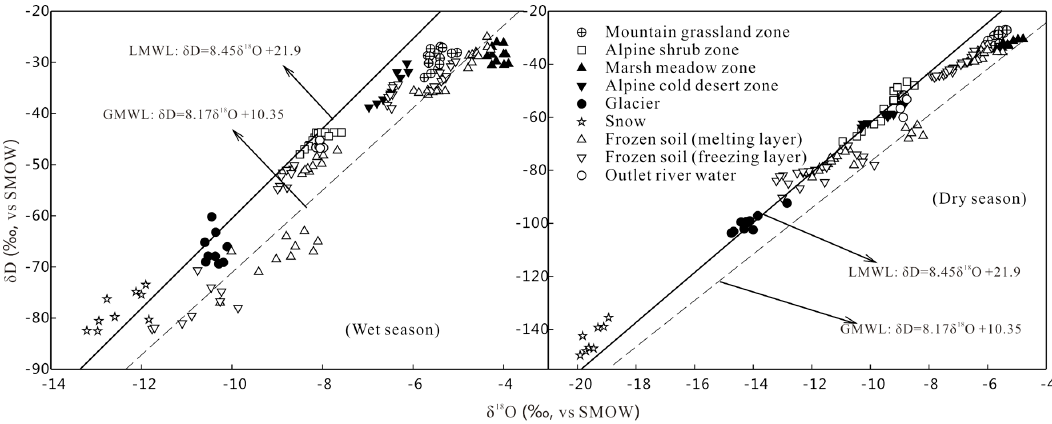
Figure 3. Plot of deuterium δ D versus δ 18 O for the various samples in the wet and dry season.